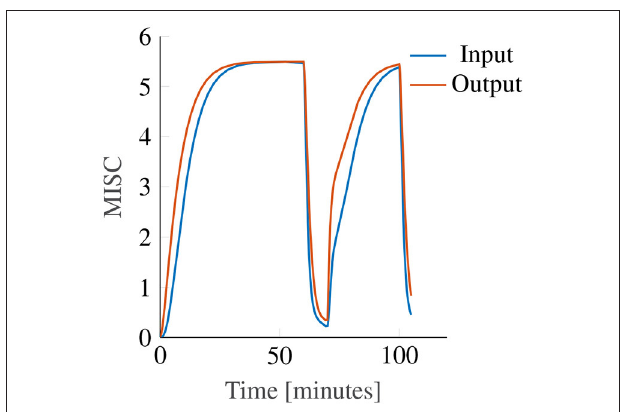
FIGURE 10 | Example showing the effect of input (blue line) and output (orange line) power scaling on the predictions of the Oman model for constant amplitude